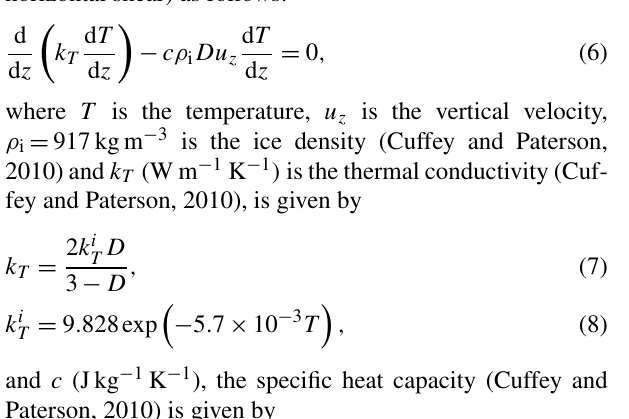
Table 1. Age and total age uncertainty of the 18 isochrones used in this